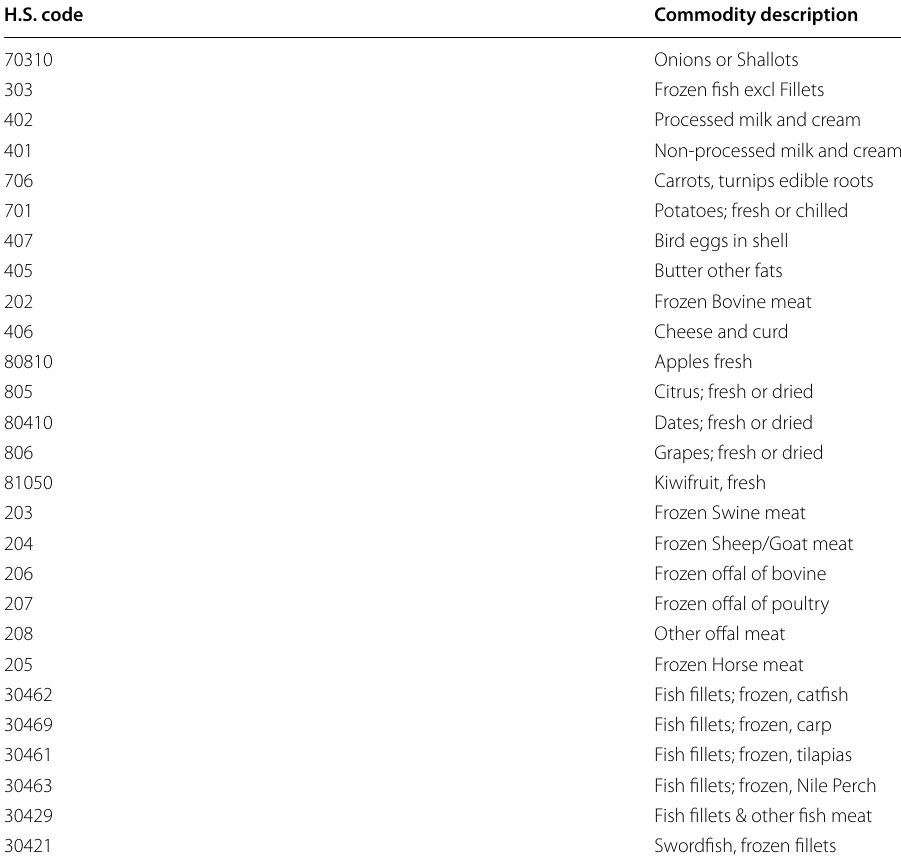
Table 12 H.S. codes for different types of commodities H.S.